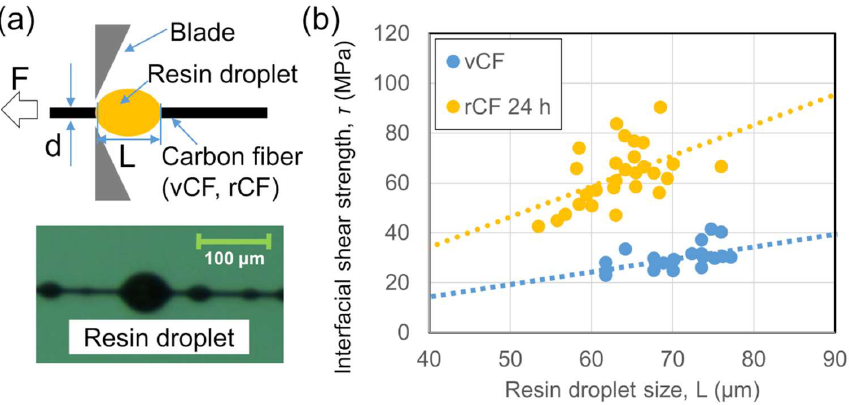
Figure A2. ( a ) Schematic image of microdroplet test, ( b ) interfacial shear strength versus embedded lengths of the resin droplet for representative plots such as vCF and rCF 24 h.